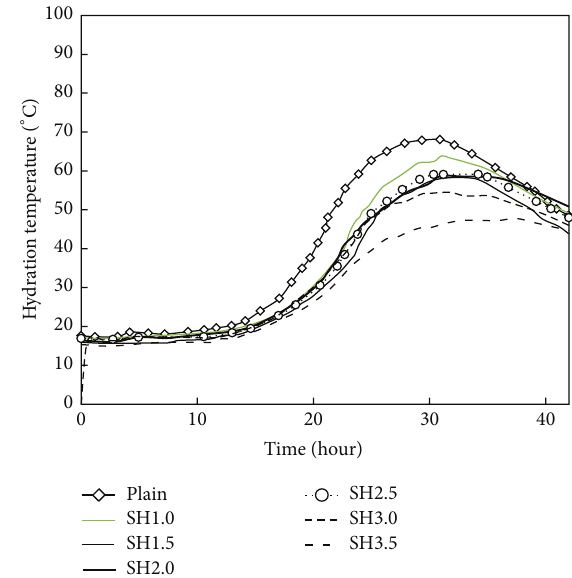
Figure 4: Results of the semiadiabatic temperature rise test accord- ing to LHM addition